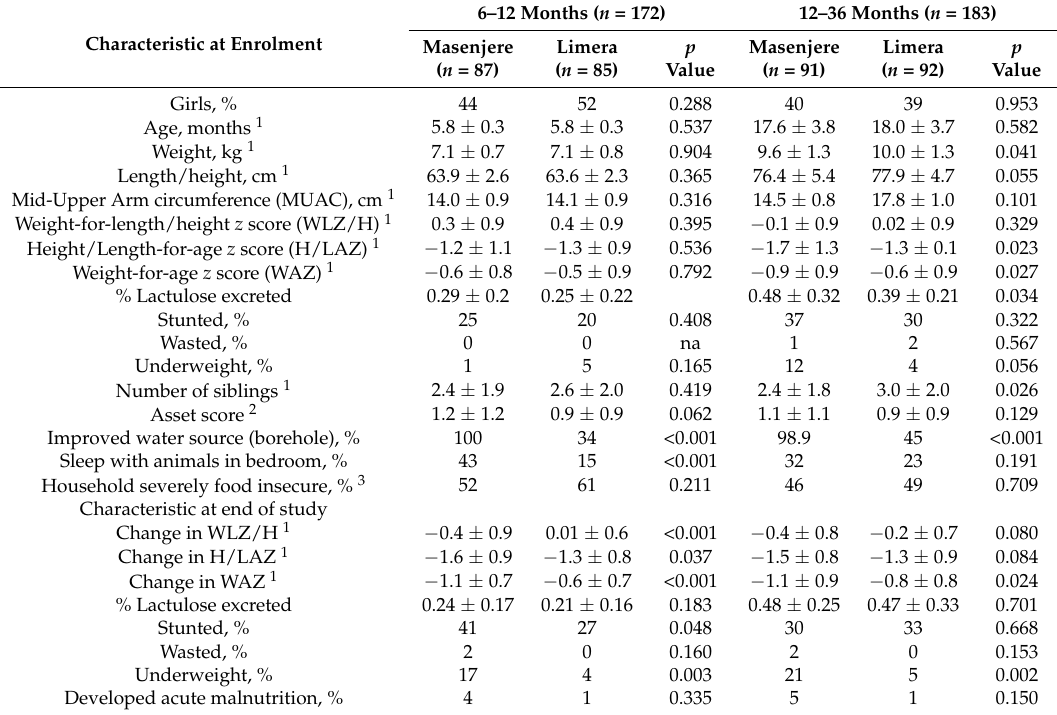
Table 1. Characteristics of 6–36-months-old Malawian children who participated in 24-h dietary recalls.